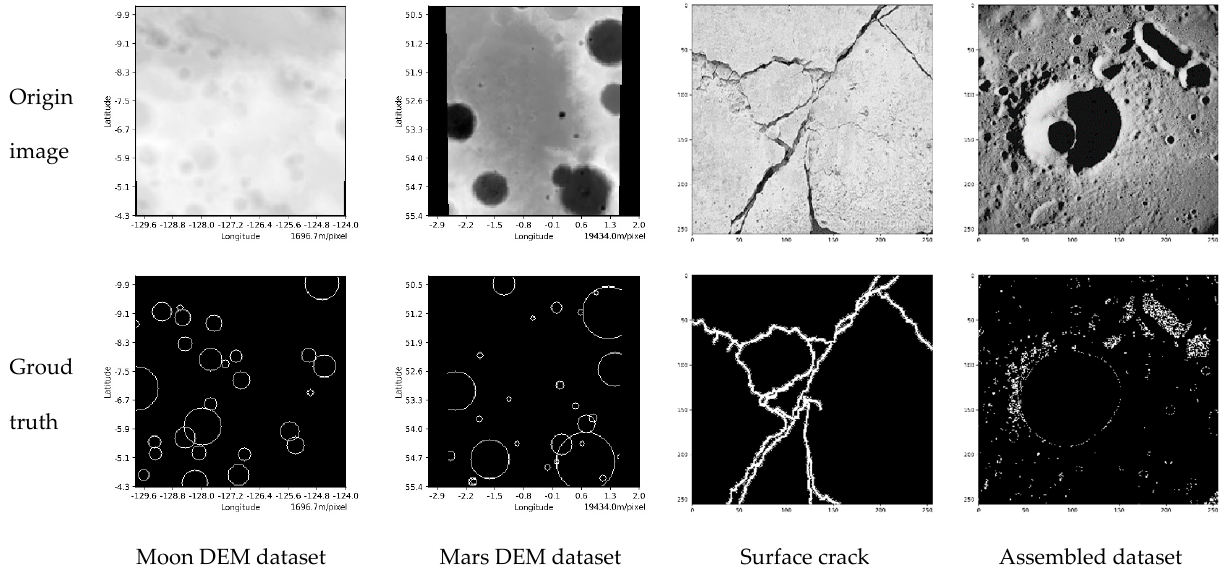
Table 1. Four different types of data sets for training, validation, and testing.